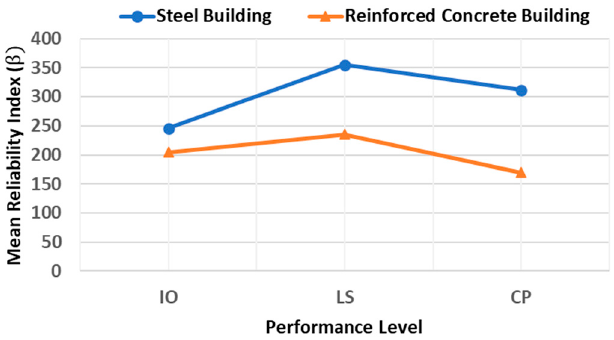
Figure 21. Mean reliability index for steel and reinforced concrete buildings located at Torreon, Coahuila (seismic zone A).